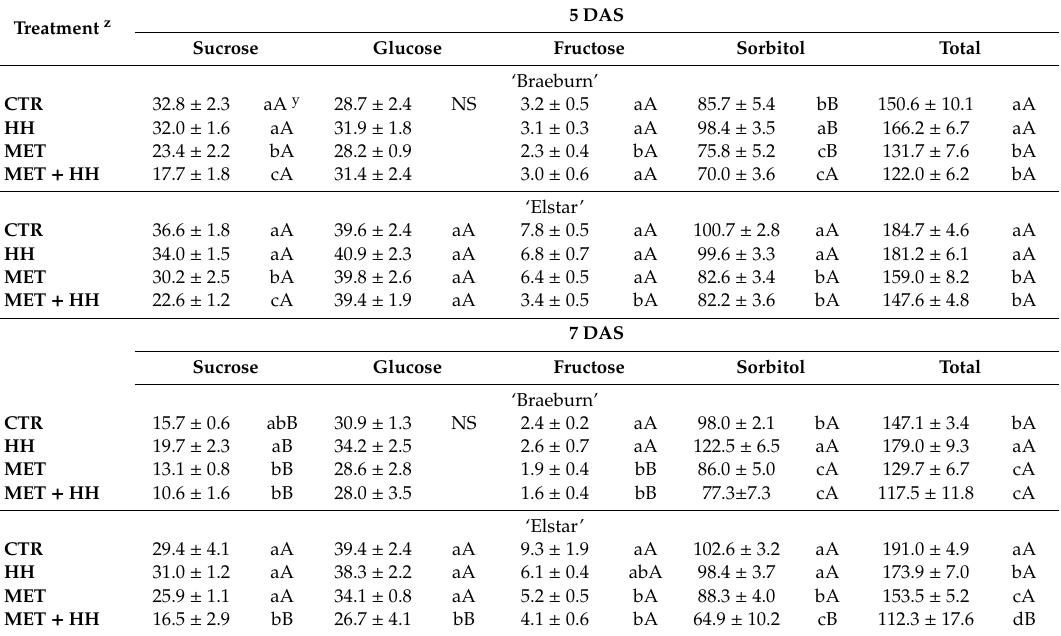
Table 2. The sucrose, glucose, fructose, sorbitol, and total sugar concentration in the leaves (mg g − 1 dry weight (DW)) evaluated 5 and 7 days after spraying (DAS) in trials with ‘Braeburn’ and ‘Elstar’ apples in Sint-Truiden, Belgium.